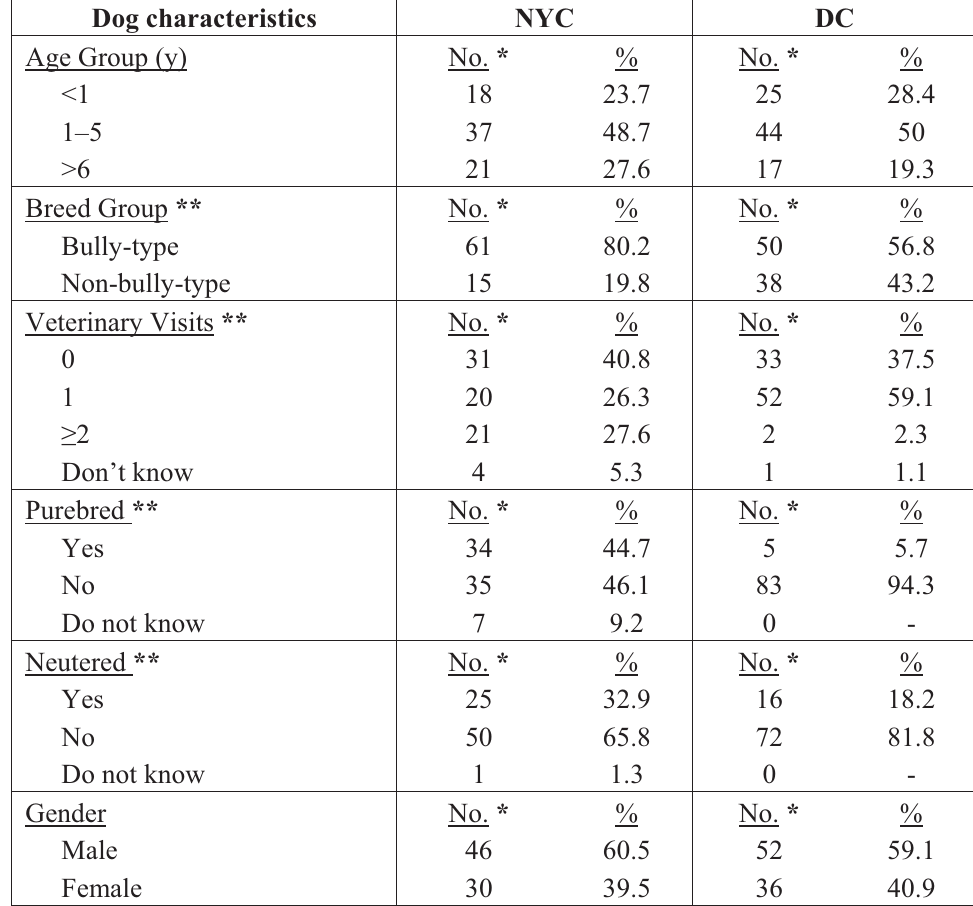
Table 2. Characteristics of large dogs surrendered to shelters in New York City and Washington,